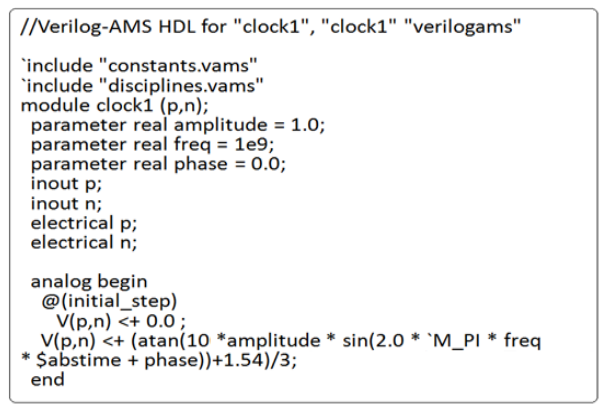
Figure 1. Verilog-A code for input signal generation.